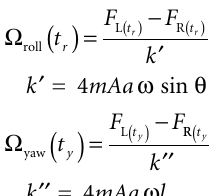
, Φ and Φ are plotted against time p r, y - F and F + F given a constant applied L R L R